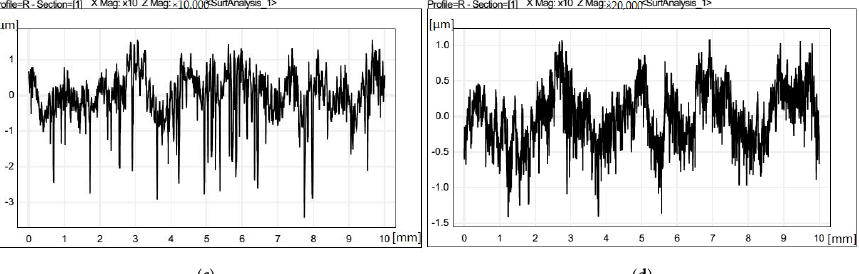
Figure 4. ( a – d ) Surface texture measurement results for sample machined with TIP1, TIP2, TIG1, and TIG2.